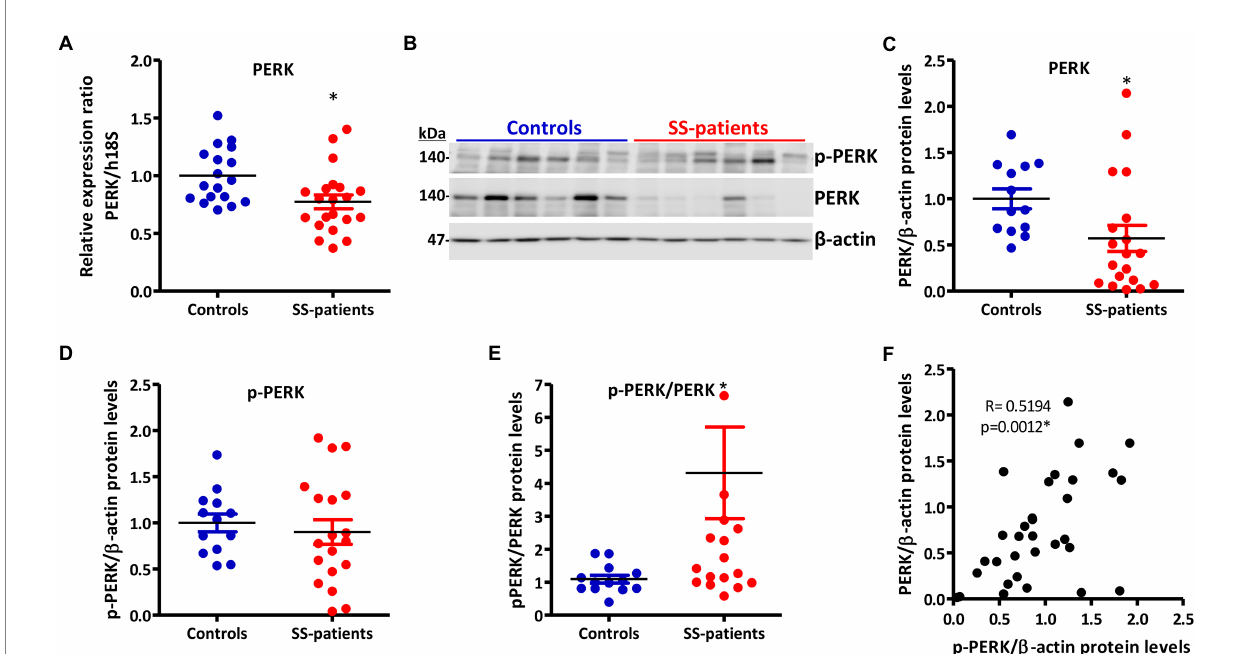
FIGURE 5 Expression and activation of PERK in LSGs from control and SS-patients. (A) Dot plot showing PERK transcript levels relative to h18S from control (C) and SS-patients (P) ( n = 18C, 21P). (B) Representative images of p-PERK and PERK immunoblots from control and SS-patients using β -actin as a loading control. (C) Dot plot showing densitometric analysis of PERK ( n = 13C, 19P). (D) Dot plot showing densitometric analysis of p-PERK ( n = 13C, 19P). (E) Dot plot showing the p-PERK/PERK ratio ( n = 13C, 19P). (F) Spearman’s correlation between p-PERK and PERK protein levels. These experiments were repeated at least three times (*). p values lower than 0.05 were considered